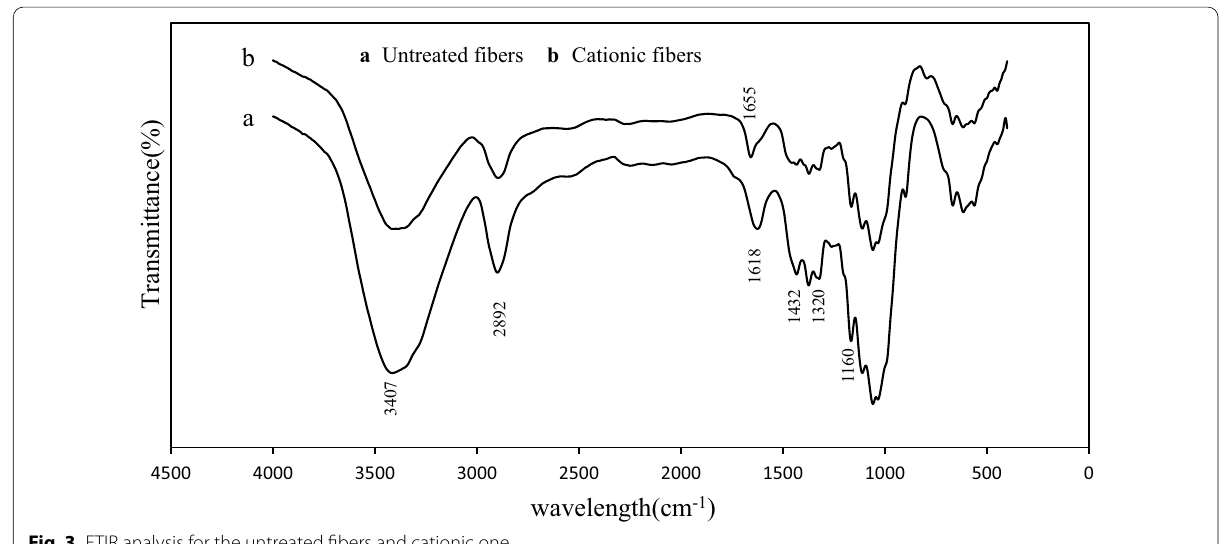
Fig. 3 FTIR analysis for the untreated fibers and cationic